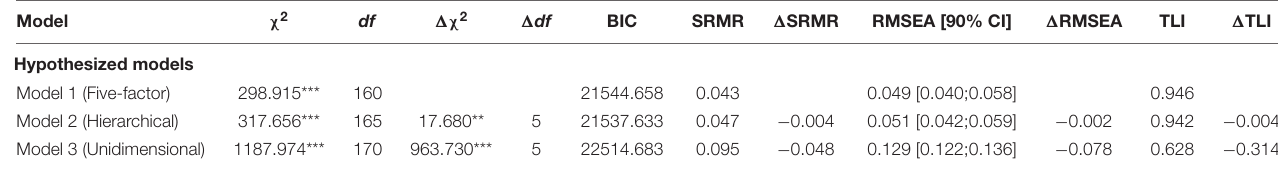
TABLE 3 | Fit indices for the tested models ( N =